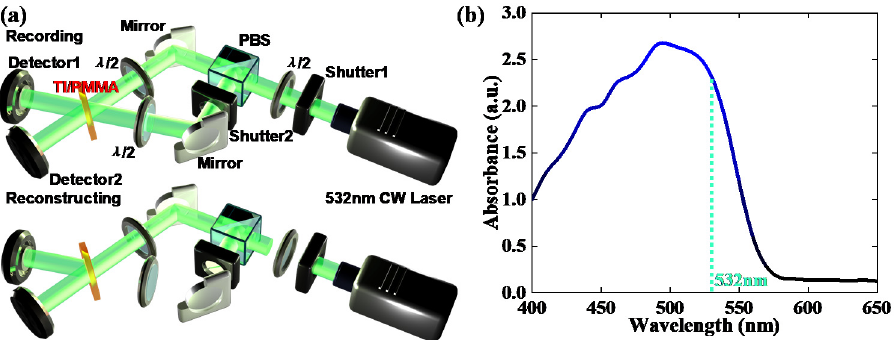
Figure 2. ( a ) Recording and reconstructing approaches for holographic measurement, ( b ) light absorption spectrum of TI/PMMA polymers at the range of 400–650 nm.